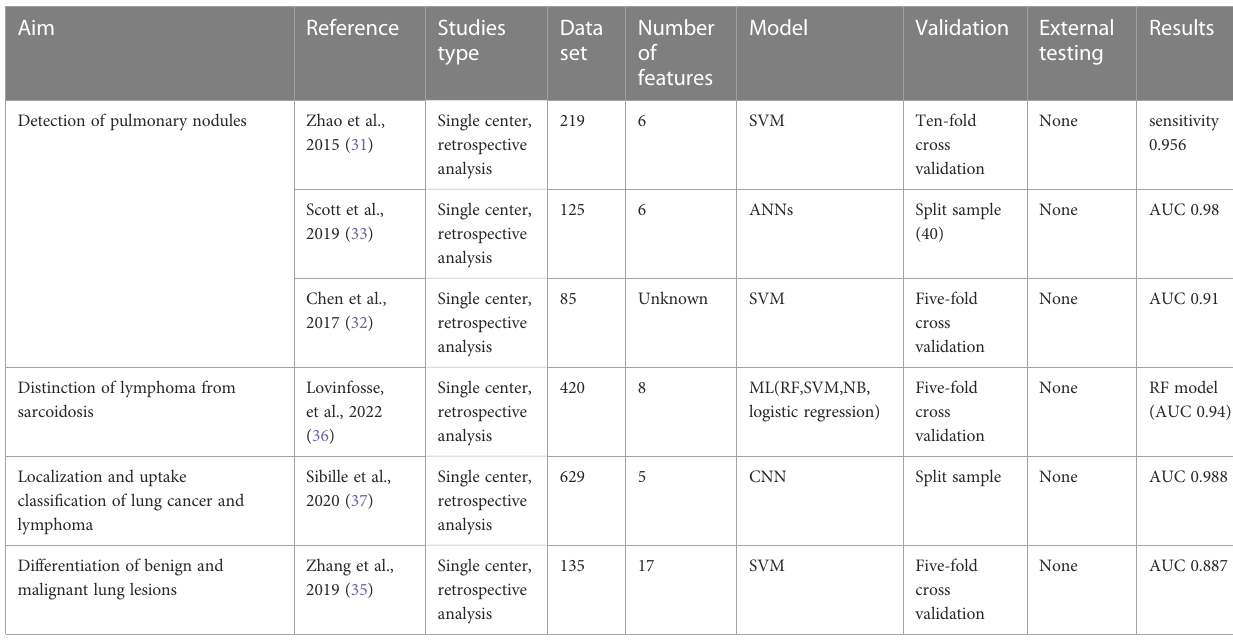
TABLE 1 Main fi ndings on lung nodule prediction of